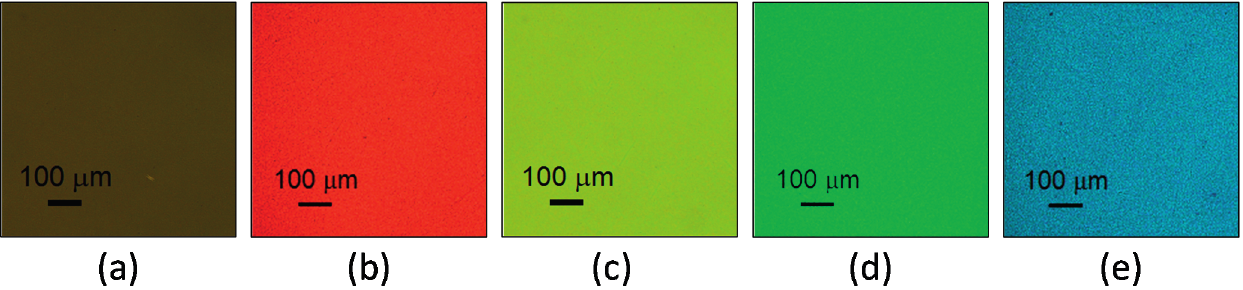
Figure 3. Polarizing optical micrographs of the polymer/ChLC nano-composites after polymerization with different chiral dopant concentrations: ( a ) 6 wt %; ( b ) 7 wt %; ( c ) 8 wt %; ( d ) 9 wt %; ( e ) 10 wt